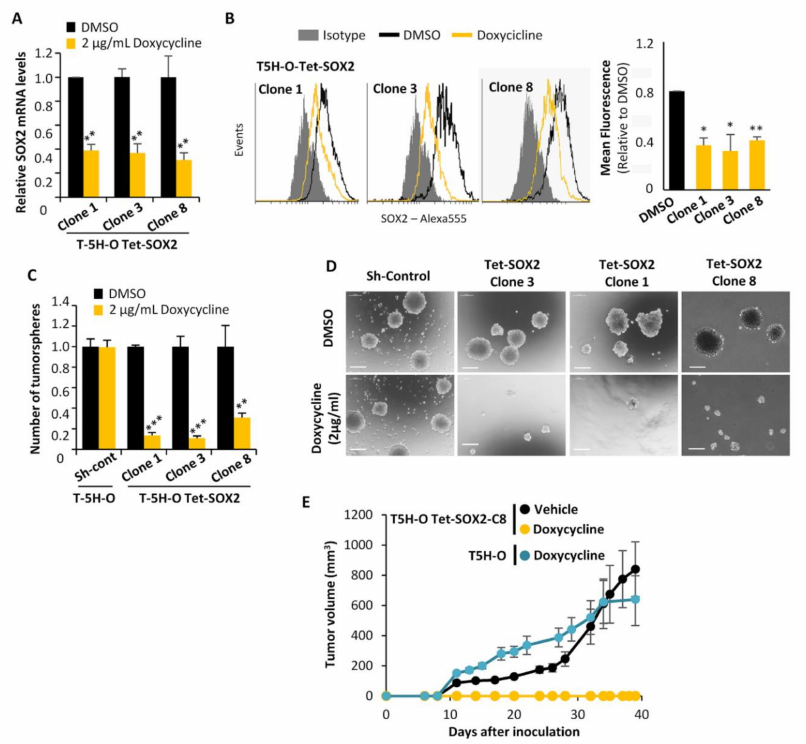
Figure 2. The depletion of SOX2 strongly reduced the tumorigenic potential of sarcoma cells. ( A , B ) Relative mRNA expression ( A ) and flow cytometry analysis ( B ) of SOX2 in three clones of T-5H-O cells carrying a doxycycline-inducible SOX2 shRNA in the presence or absence of 2 µ g / mL doxycycline for 48 h. ( C , D ) Average number of three independent experiments ( C ) and representative images ( D ) of tumorspheres formed by the parental T-5H-O cells transduced with control ShRNA or the T-5H-O clones carrying a doxycycline-inducible SOX2 shRNA in the presence or absence of 2 µ g / mL doxycycline for 48 h. Scale bars = 200 µ m. ( E ) T-5H-O and T-5H-O-Tet-SOX2-C8 cells were pretreated as indicated with vehicle (DMSO) or 2 µ g / mL doxycycline for 72 h prior to the subcutaneous inoculation of 1 × 10 4 cells in immunodeficient mice ( n = 7 mice per series). Upon inoculation mice were treated daily with vehicle (saline) or doxycycline (50 mg / kg) via intraperitoneal. Tumor growth (mean volume) kinetics of each series are represented. Error bars represent the standard deviation and asterisks indicate statistically significant di ff erences with control groups (*: p < 0.05, **: p < 0.005, ***: p < 0.0005; two-sided Student t